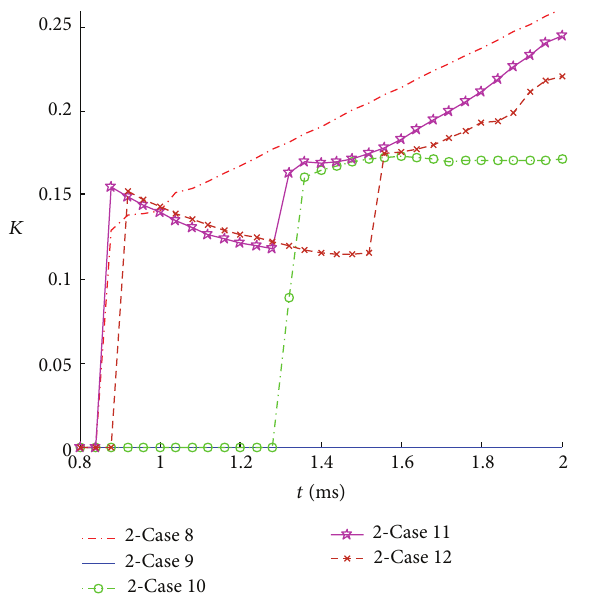
Figure 21: The crevasse variation of inner shell with full interlayer water; cases are shown in Table